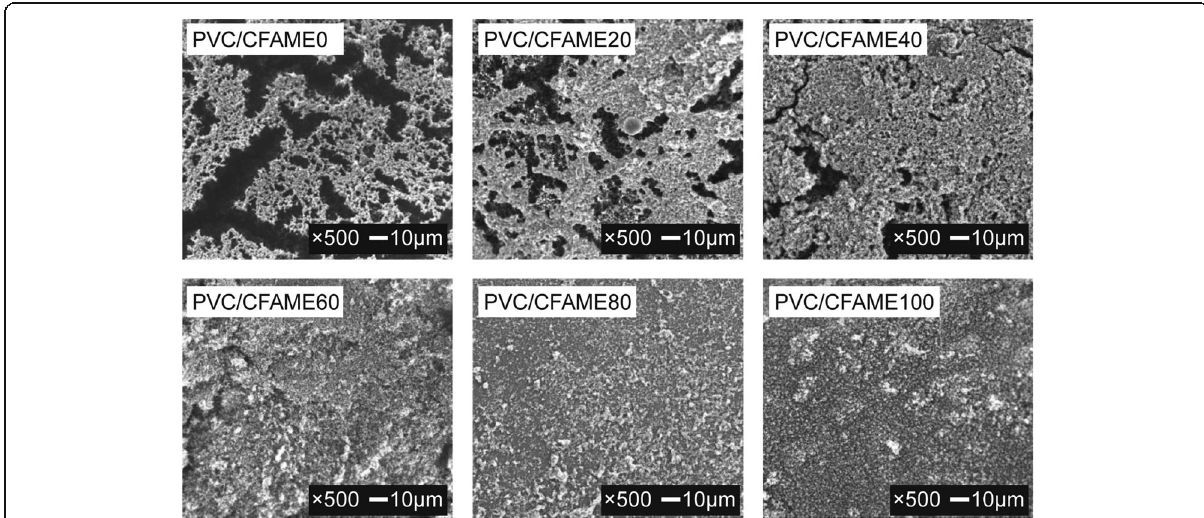
Fig. 8 SEM images concerning the surface morphology of char residues obtained from LOI experiment